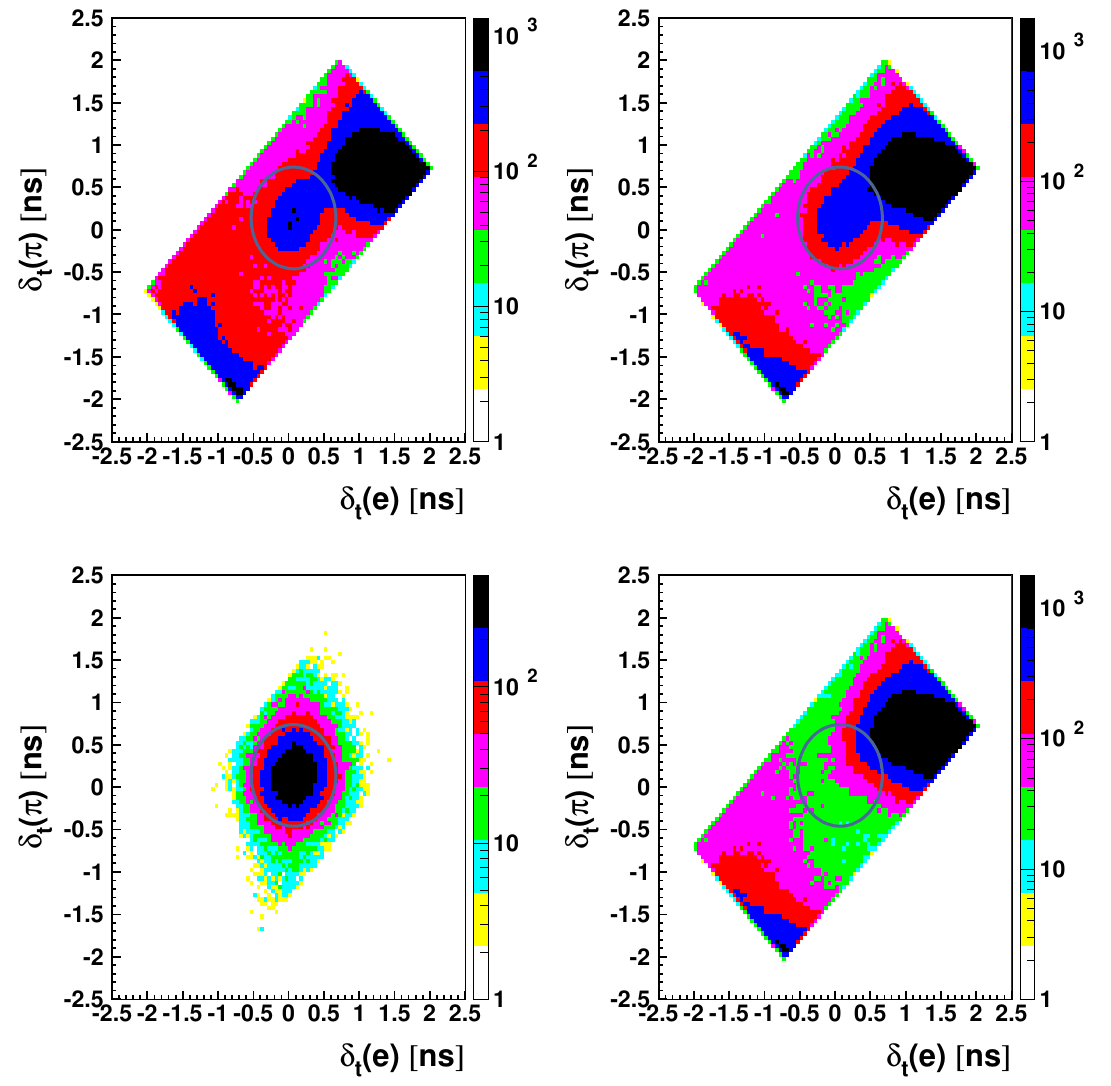
Figure 3 . Distribution of the time di(cid:11)erences (cid:14) t ( (cid:25) ) vs. (cid:14) t ( e ) for data events (top-left), all simulated events (top-right), simulated K S ! (cid:25)e(cid:23) events (bottom-left) and simulated background events (bottom-right). Events within the circle [( (cid:14) t ( e ) (cid:0) 0 : 07 ns)] 2 + [( (cid:14) t ( (cid:25) ) (cid:0) 0 : 13 ns)] 2 = (0 : 6 ns) 2 are retained for the